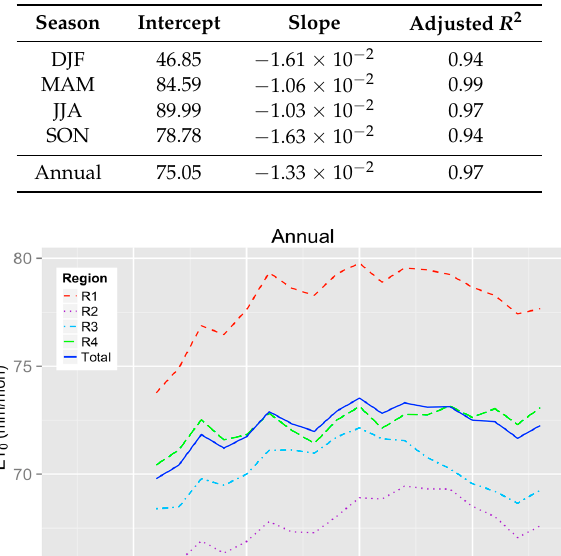
Table 2. Relationships between ET 0 based on extended data and elevations below 1500 m a.s.l.